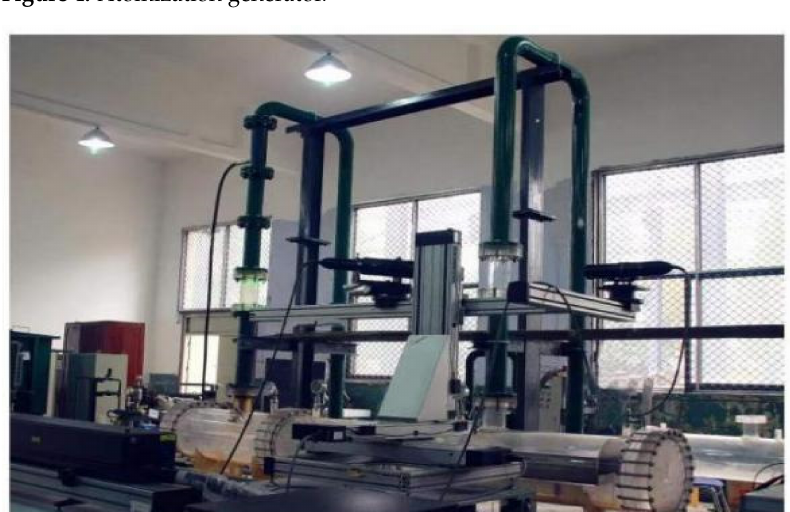
Figure 5. Experimental site.